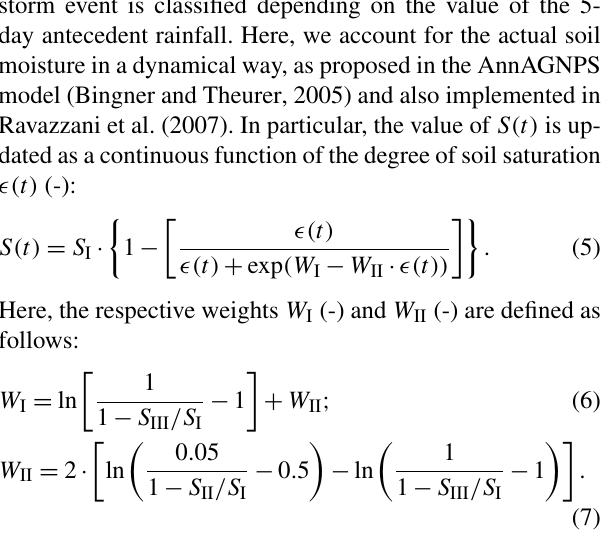
abstraction (calculated as a percentage, 20 %, of S ).